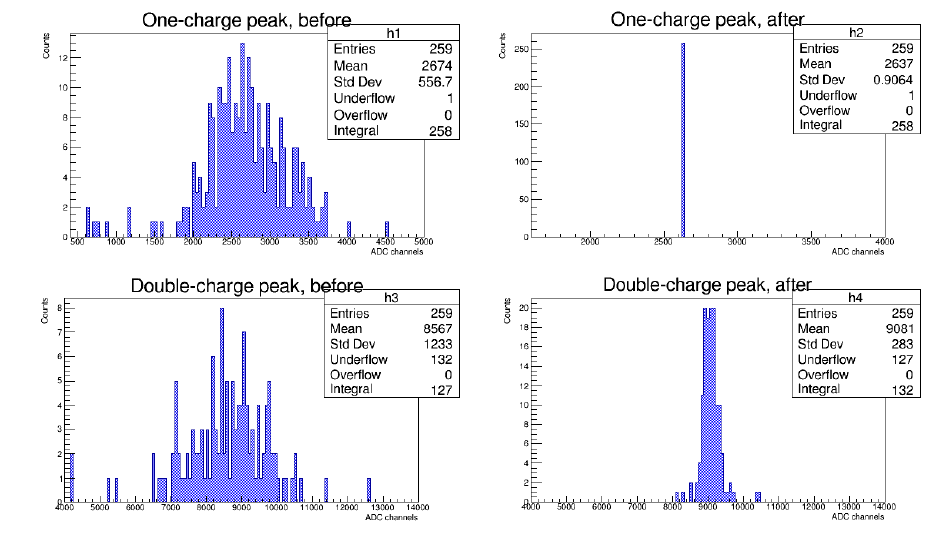
Figure 2. Preliminary beam calibration